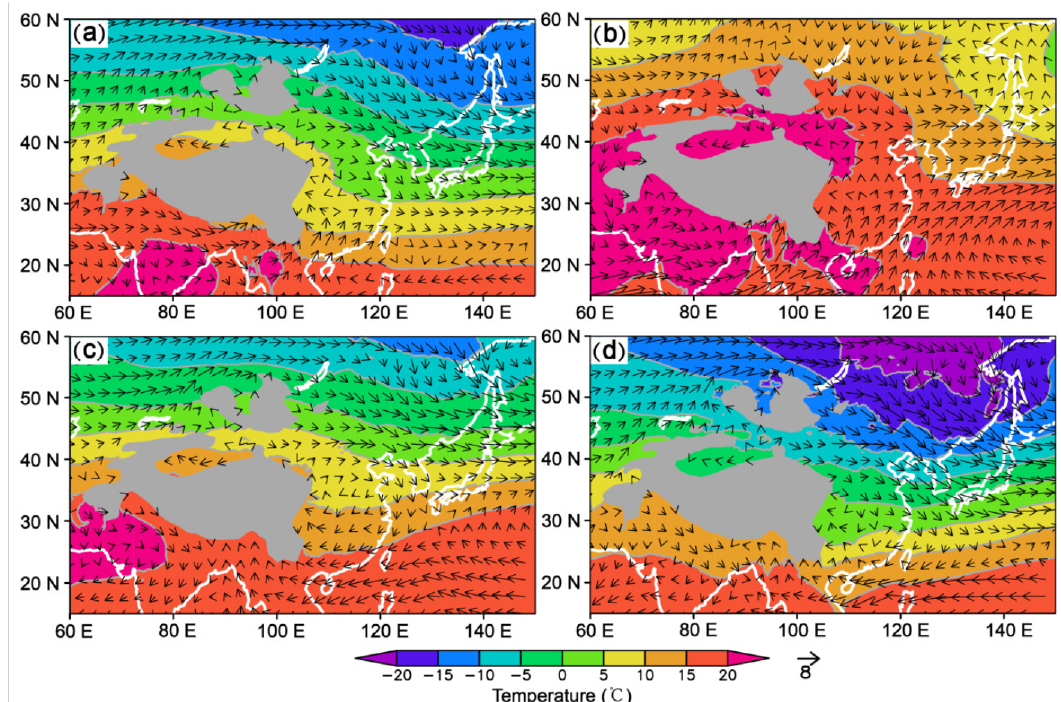
Figure 5. ECMWF-reanalyzed 850 hPa temperature (shaded; units: ◦ C) and wind vector (arrow; units: m · s − 1 ) fields for March ( a ), June ( b ), October ( c ), and December ( d ) averaged over the three years (2016–2018). The Qinghai-Tibet Plateau and the Mongolian Plateau are